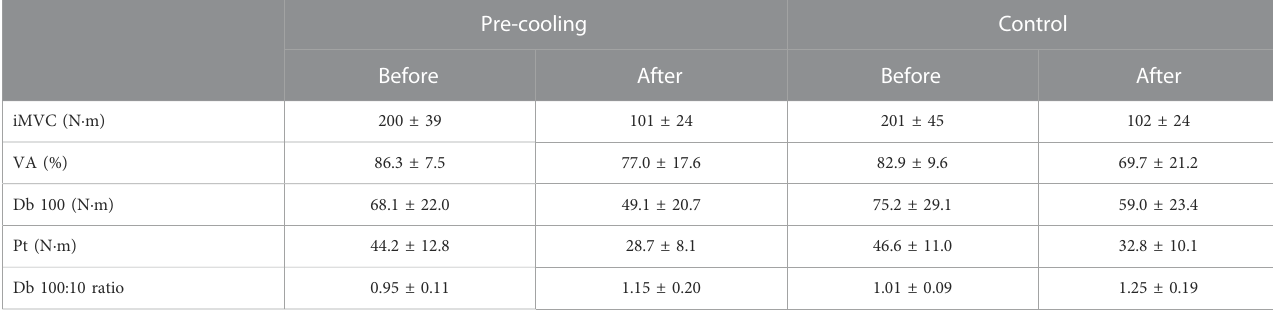
TABLE 1 Neuromuscular response before and after the fatiguing task (60 intermittent iMVC maintained over 3 s and spaced by 2 s of recovery). Pre-cooling Control Before After Before After